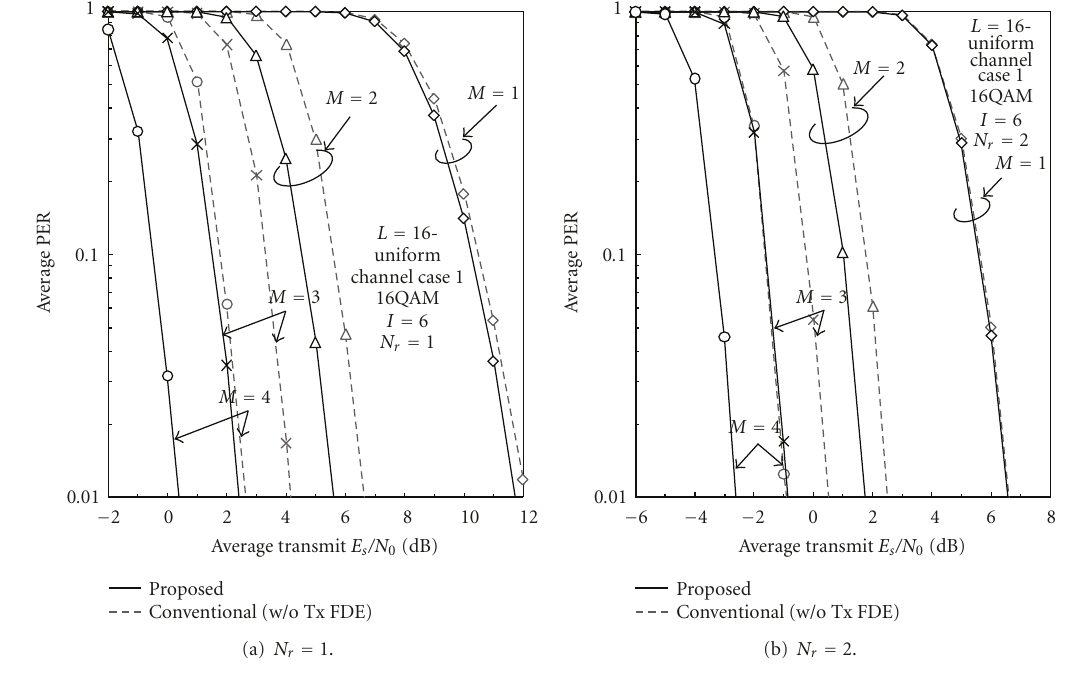
Figure 7: Average PER performance when M = 1,2,3,and